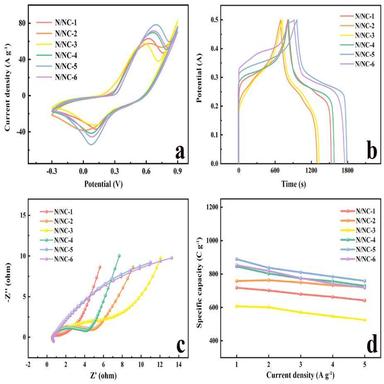
The electrochemical properties of N/NC-1 to N/NC-6 at different molar ratios of Ni(NO3)2⋅6H2O to Co(NO3)2⋅6H2O. CV curves at 30 mV s − 1 (a), GCD curves at 1 A g− 1 (b), the Nyquist plots of impedance data (c) and specific capacity at various current densities from 1 A g− 1 to 5 A g− 1 (d).